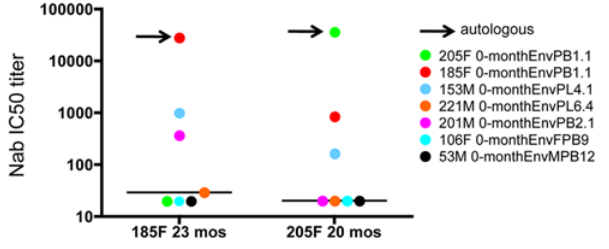
Figure 2. Moderate neutralization breadth of plasma from 185F and 205F against heterologous 0-month Envs. A single plasma sample from 185F (23-months) and 205F (20-months) was evaluated for neutralizing activity against heterologous Envs acquired during acute/early subtype C infection of six subjects. The Nab IC50 titer for each plasma-Env combination is shown on the vertical axis on a log10 scale. Each data point represents a single plasma-Env combina- tion. Arrows indicate the Nab IC50 titer for the autologous plasma-Env combination; all other data points represent heterologous Envs. The plasma sample is indicated below each point plot.